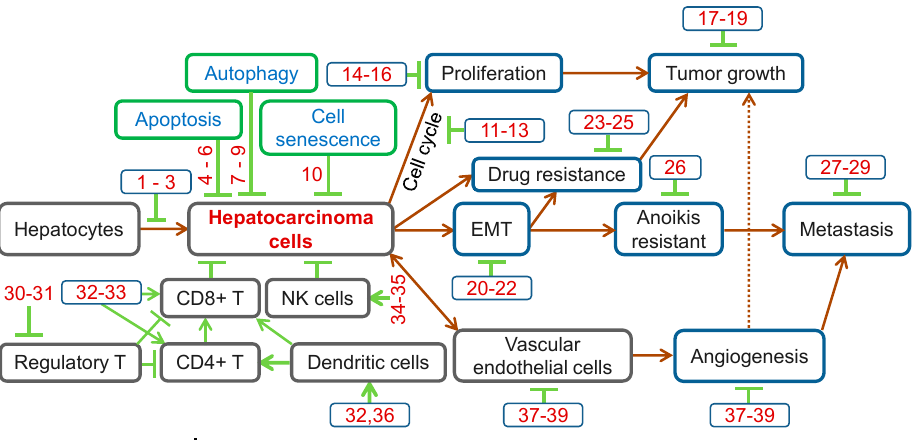
Figure 1. Anti-cancer effects of herbal compounds against hepatocarcinoma. 1, Ursolic acid; 2, Penta-acetyl geniposide; 3, Curcumin; 4, Matrine; 5, Solamargine; 6, Ponicidin; 7, Tetrandrine; 8,